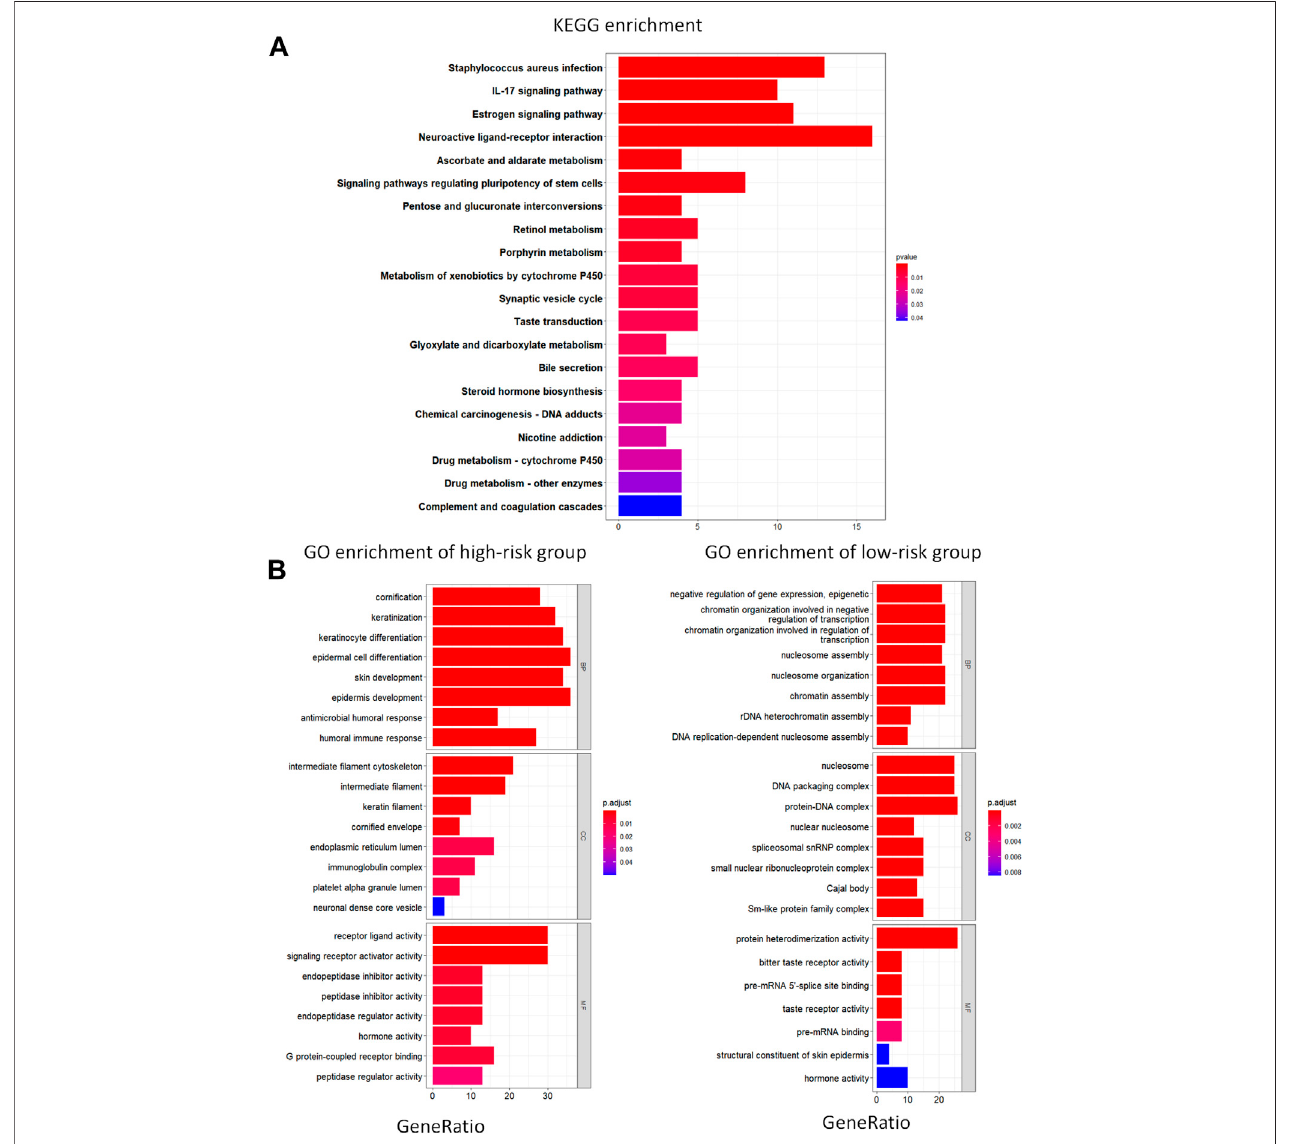
FIGURE4| KEGGandGOenrichmentanalysis. (A) KEGGanalysisofdifferentiallyexpressedmetabolicgenes. (B) GOpathwayenrichmentanalysisofdifferentially expressed metabolic genes for high- and low-risk groups. BP represents biological process, CC represents cellular component and MF represents molecular function.